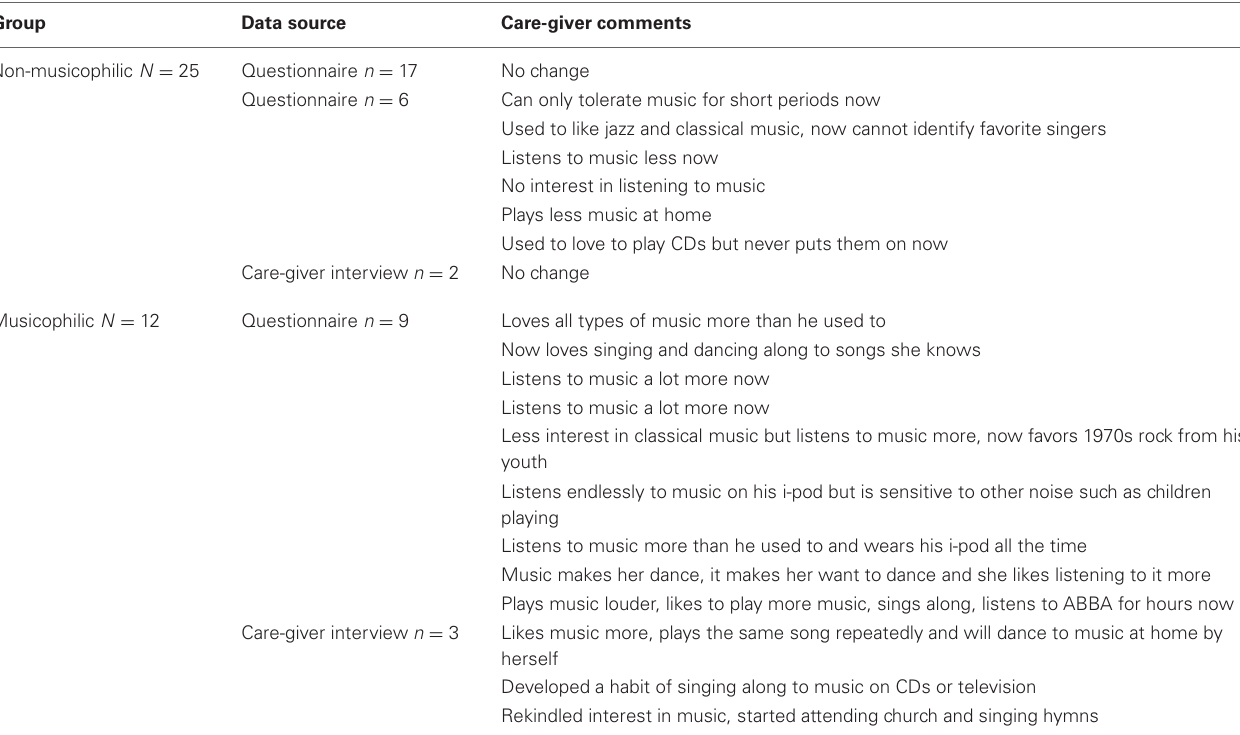
Table A1 | Summary of changes in music listening in patient